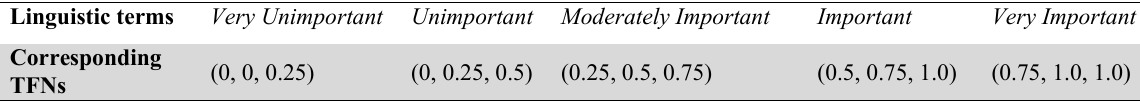
Linguistic terms and the corresponding triangular fuzzy number of five-point likert scale Linguistic terms Very